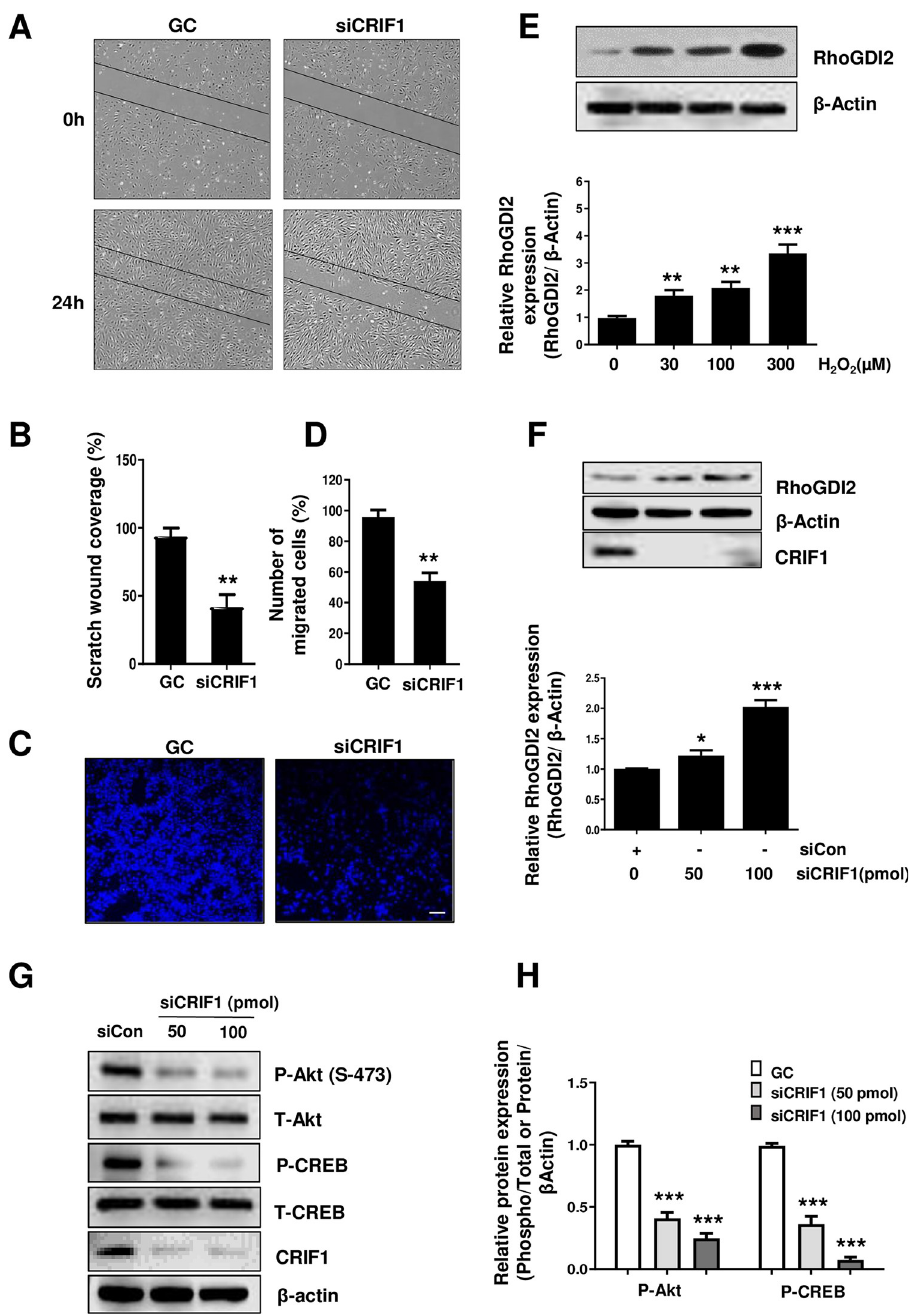
Fig 1. Effect of CRIF1 deficiency on cell migration and RhoGDI2 expression in endothelial cells. (A) HUVECs were cultured in six-well plates, transfected with control or CRIF1 siRNA (100 pmol), and incubated for 24 h. Next, the cells were wounded for 24 h. Images were obtained using a light microscope. (B) Quantification of wound closure was performed using ImageJ software. (C) HUVECs were transfected with control or CRIF1 siRNA (100 pmol) and transwell assay was conducted to determine cell migration. Scale bar 200 μ m. (D) Quantification of the number of migrated cells was performed using ImageJ software. (E) Western blot analysis of RhoGDI2 in HUVECs treated with the indicated doses of H 2 O 2 for 24 h. β -actin was used as an internal control. RhoGDI2 protein level quantified by densitometric analysis using ImageJ software is shown in the down panel. (F) Western blot analysis of RhoGDI2 after 48 h of dose-dependent CRIF1 siRNA transfection. β -actin was used as an internal control. RhoGDI2 protein level quantified by densitometric analysis using ImageJ software is shown in the down panel. (G) Western blot of phospho- Akt and phospho-CREB levels in HUVECs after 48 h of CRIF1 siRNA transfection. β -actin was used as an internal